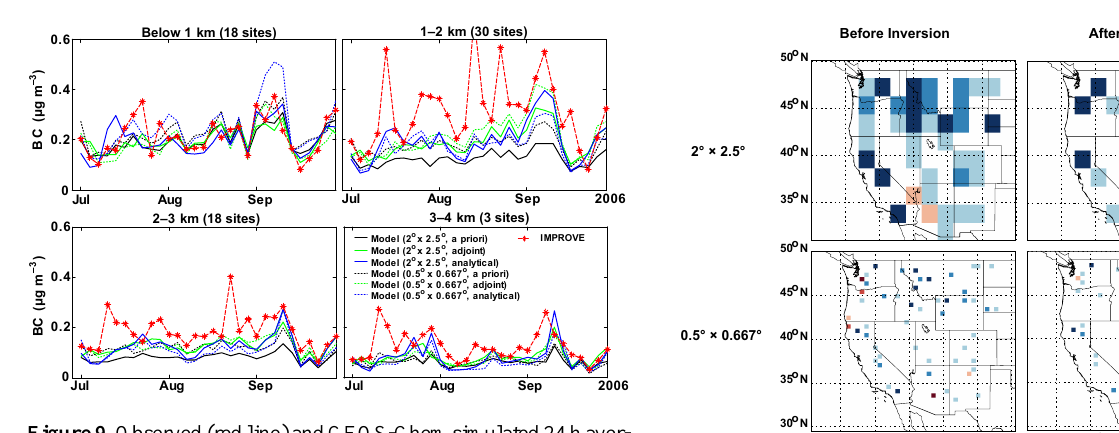
Figure 9. Observed (red line) and GEOS-Chem simulated 24h aver- age surface BC concentrations (µgm − 3 ) for July–September 2006, averaged for the IMPROVE sites (Fig. 1) in altitudes below 1km (18 sites), 1–2km (30 sites), 2–3km (18 sites), and above 3km (3 sites). Results are for 2 ◦ × 2.5 ◦ (solid line) and 0.5 ◦ × 0.667 ◦ (dot- ted line) with the a priori (black line) or a posteriori emissions from the analytical (blue line) or adjoint (green line) inversions.